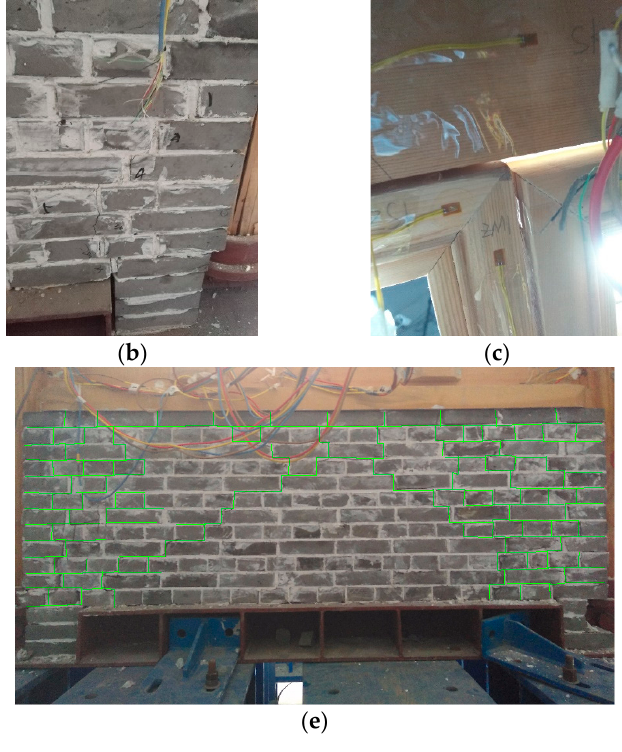
Figure 10. Test setup.